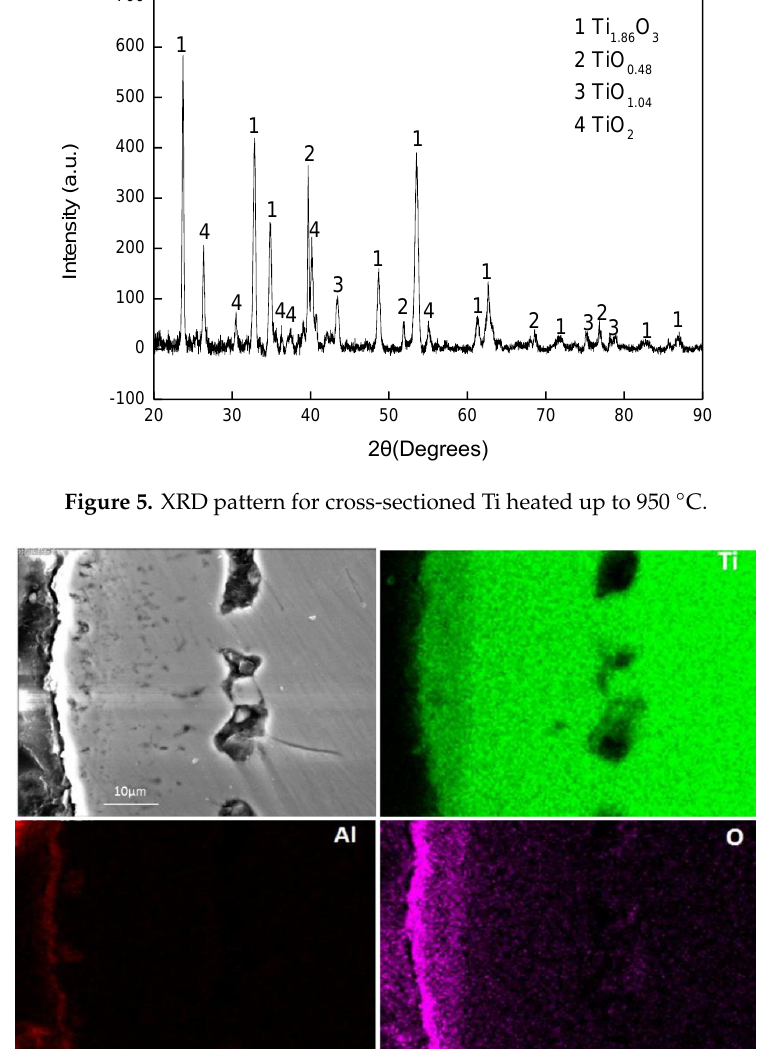
Figure 6. SEM image and EDS mapping for cross-sectioned Ti heated up to 950 °C.